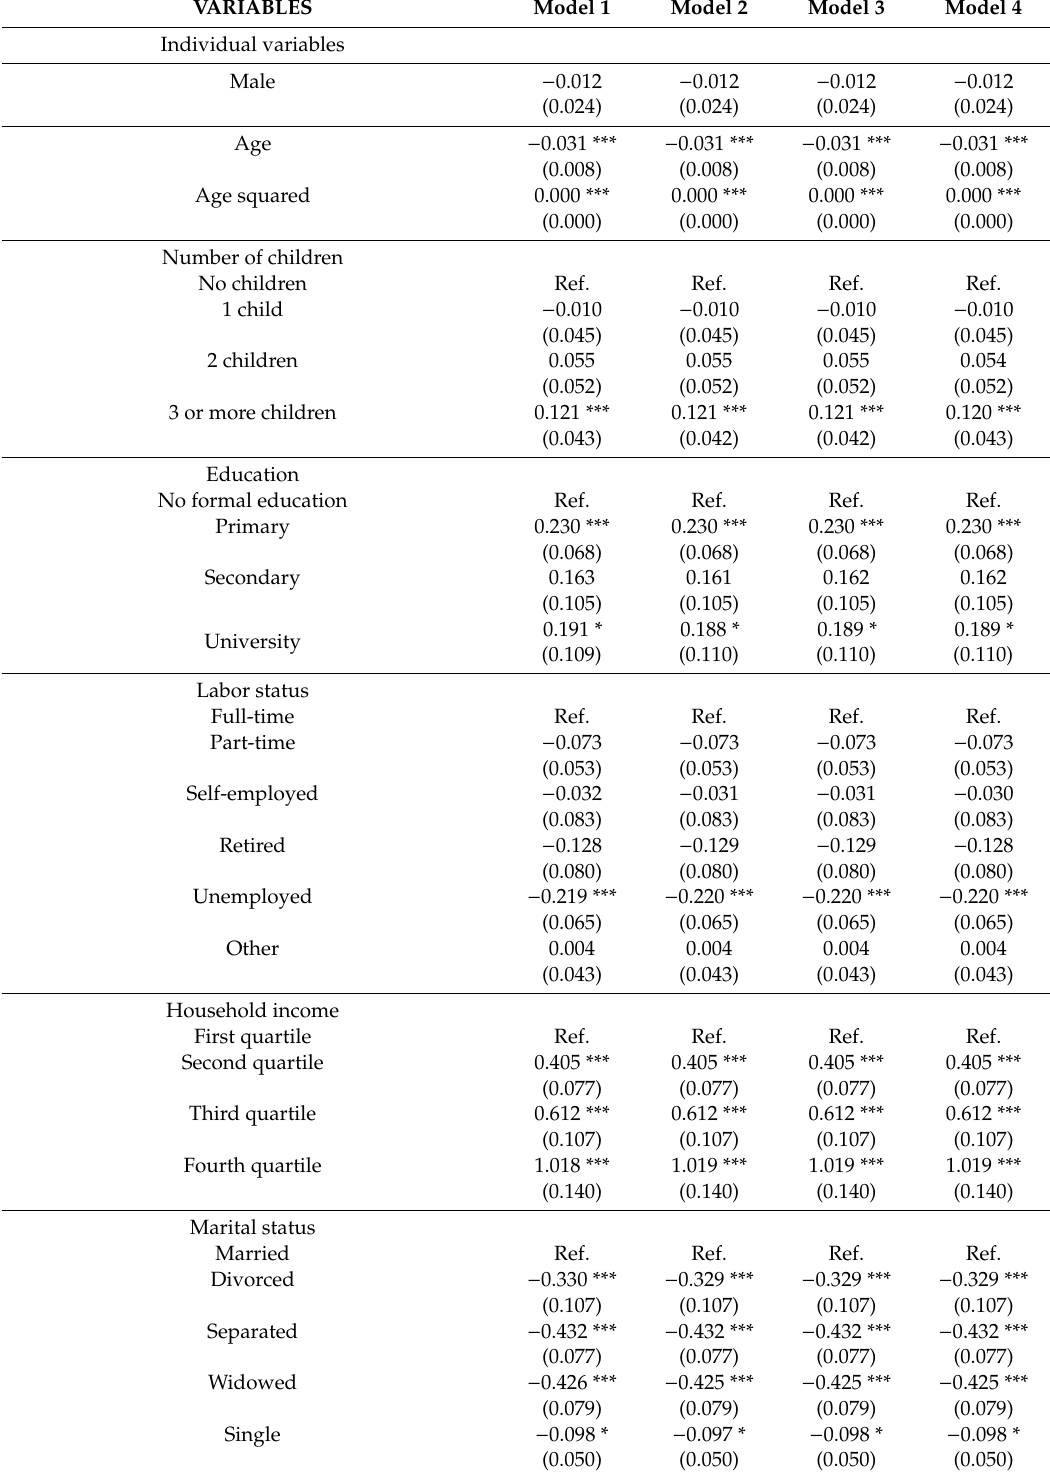
Table 1. Determinants of life satisfaction, multilevel regression